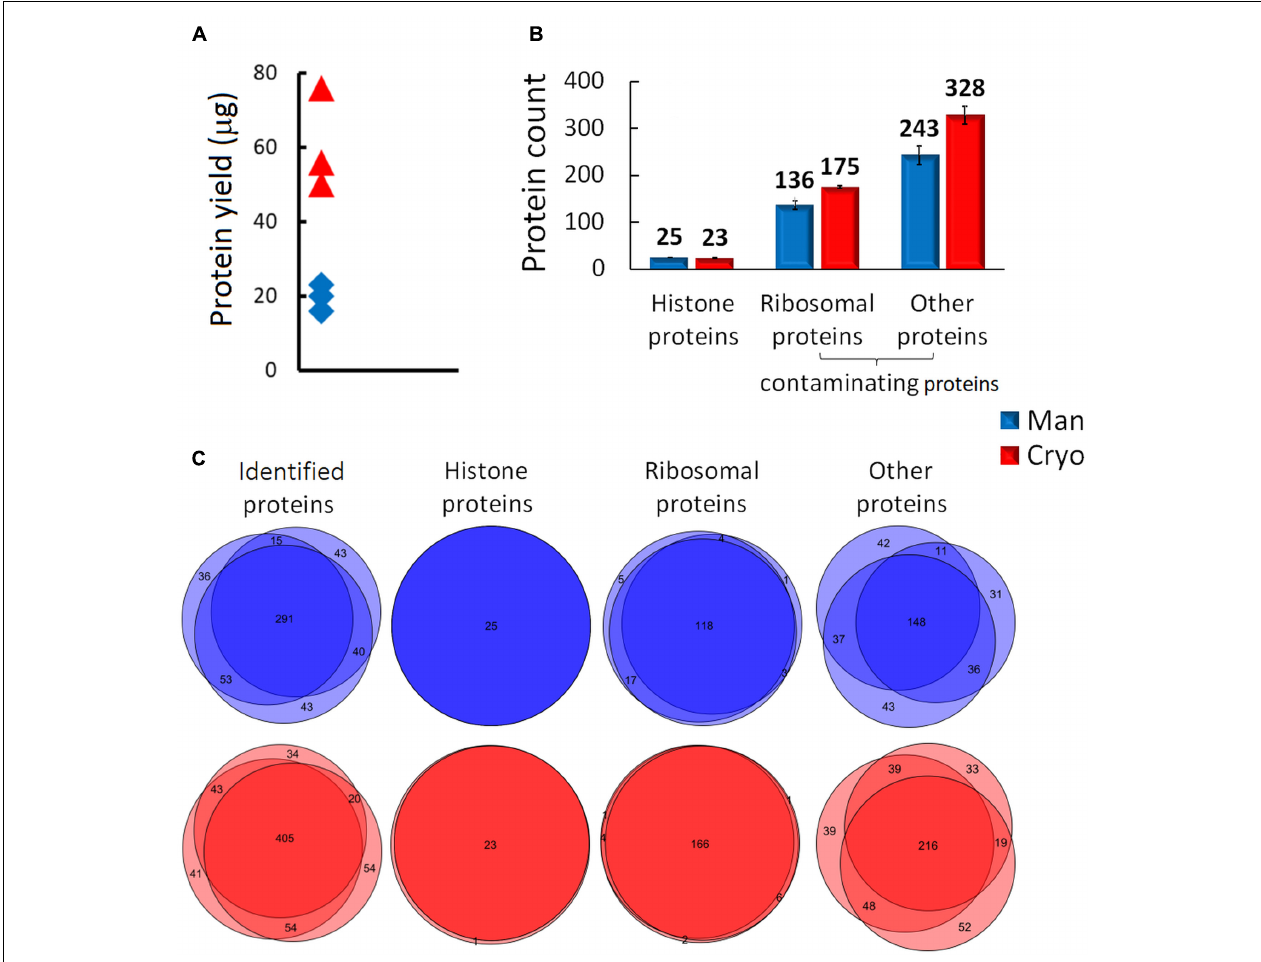
FIGURE 3 | Comparison of the quality of histone protein extracts obtained by manual plant tissue homogenization (Man) and using a cryomill (Cryo). (A) Differences in protein yield, (B) distributions of identified proteins (means and SD, N = 3) and (C) Venn diagrams displaying the number of overlapping protein groups identified in biological